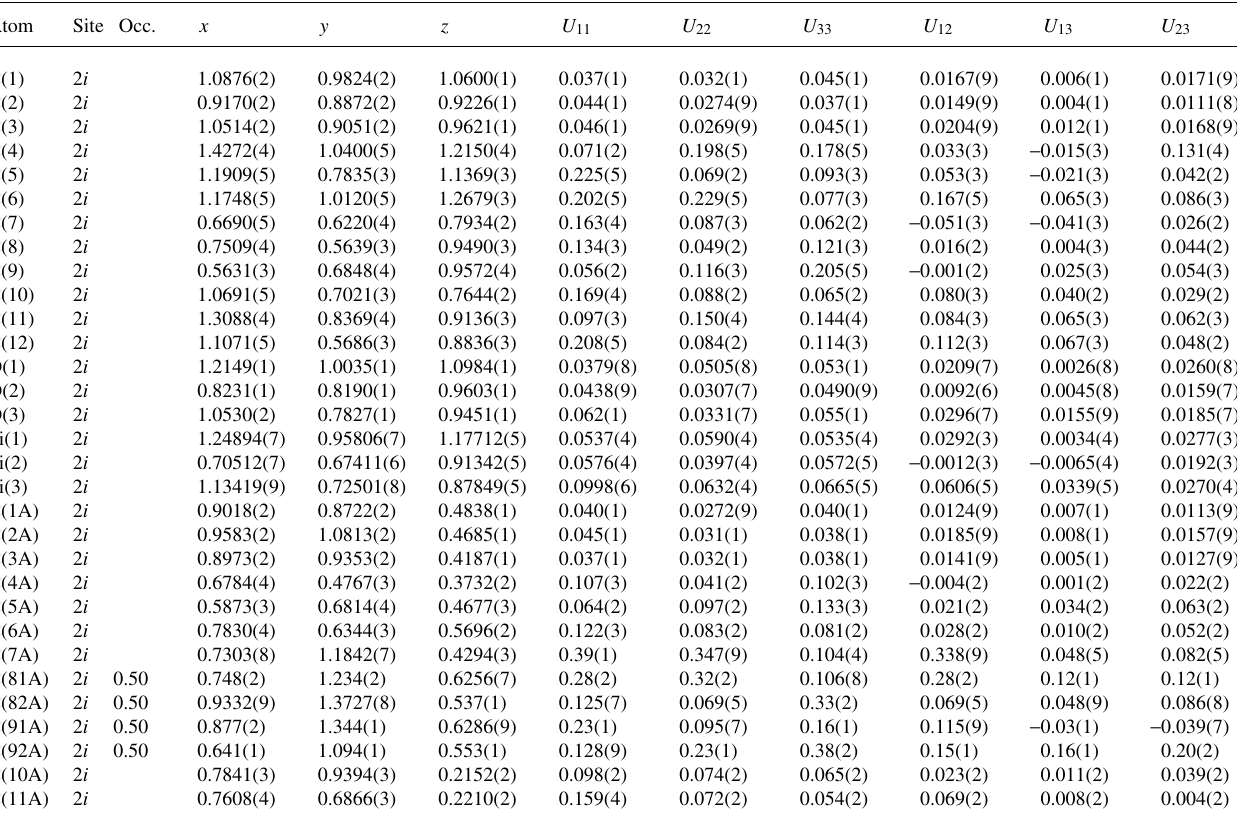
Table 3. Atomic coordinates and displacement parameters (in Å 2 ) .